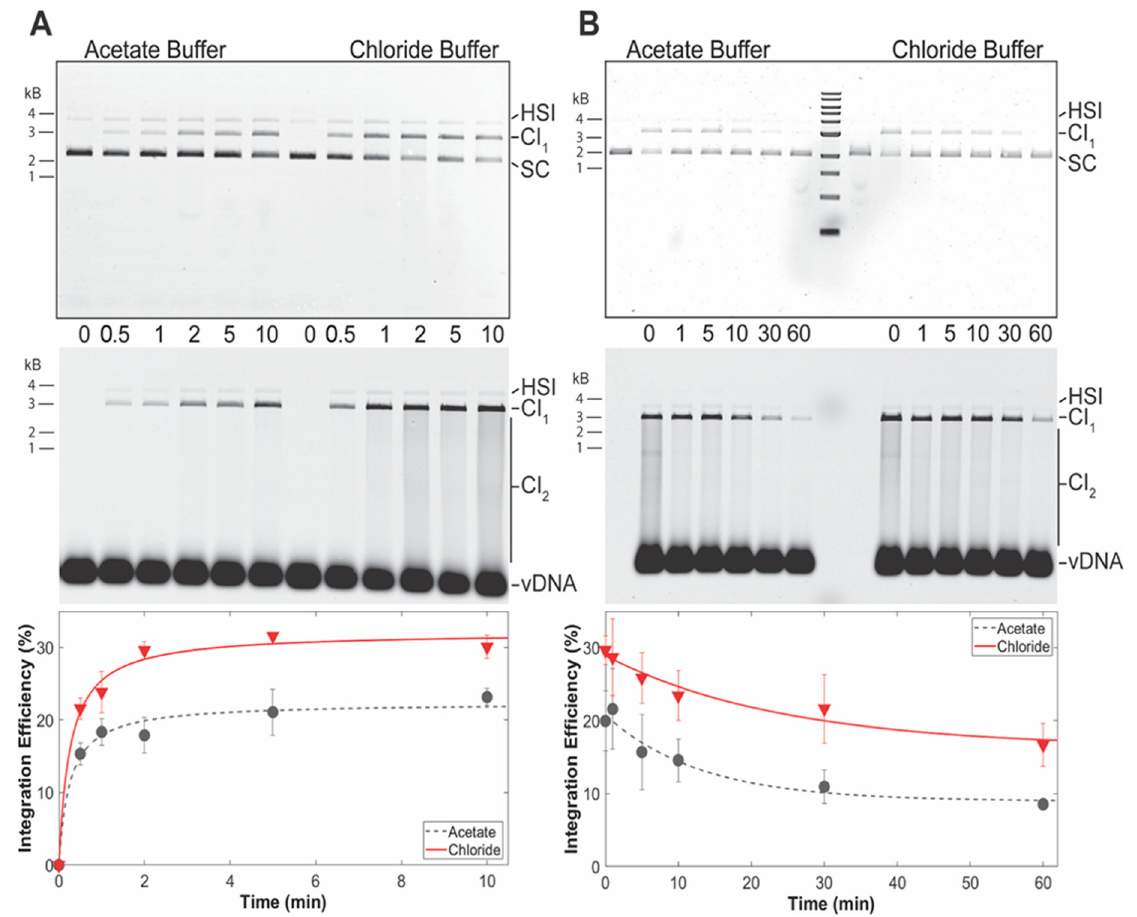
Figure 6. PFV intasomes are more active in chloride buffers. ( A ) PFV integration over time was assayed in the presence of standard chloride buffer or an acetate buffer; ( B ) PFV intasomes were diluted in chloride or acetate buffer and kept on ice for variable time before the addition of target DNA and immediate transfer to 37 ◦ C. Reaction products were resolved by agarose gel electrophoresis. The gel was imaged for ethidium bromide (top) and Cy5 (center) fluorescence. Half site integration (HSI), the first concerted integration product (CI 1 ), and subsequent concerted integration products (CI 2 ) are shown. Unreacted supercoiled plasmid target DNA (SC) is visible on in the ethidium bromide image. Unreacted vDNA is only visible in the Cy5 image. The total Cy5 fluorescence in each lane was quantified and each integration product calculated as the fraction of the total fluorescence (bottom). The average of three independent experiments with at least two independent intasomes preparations is shown. Error bars indicate the standard